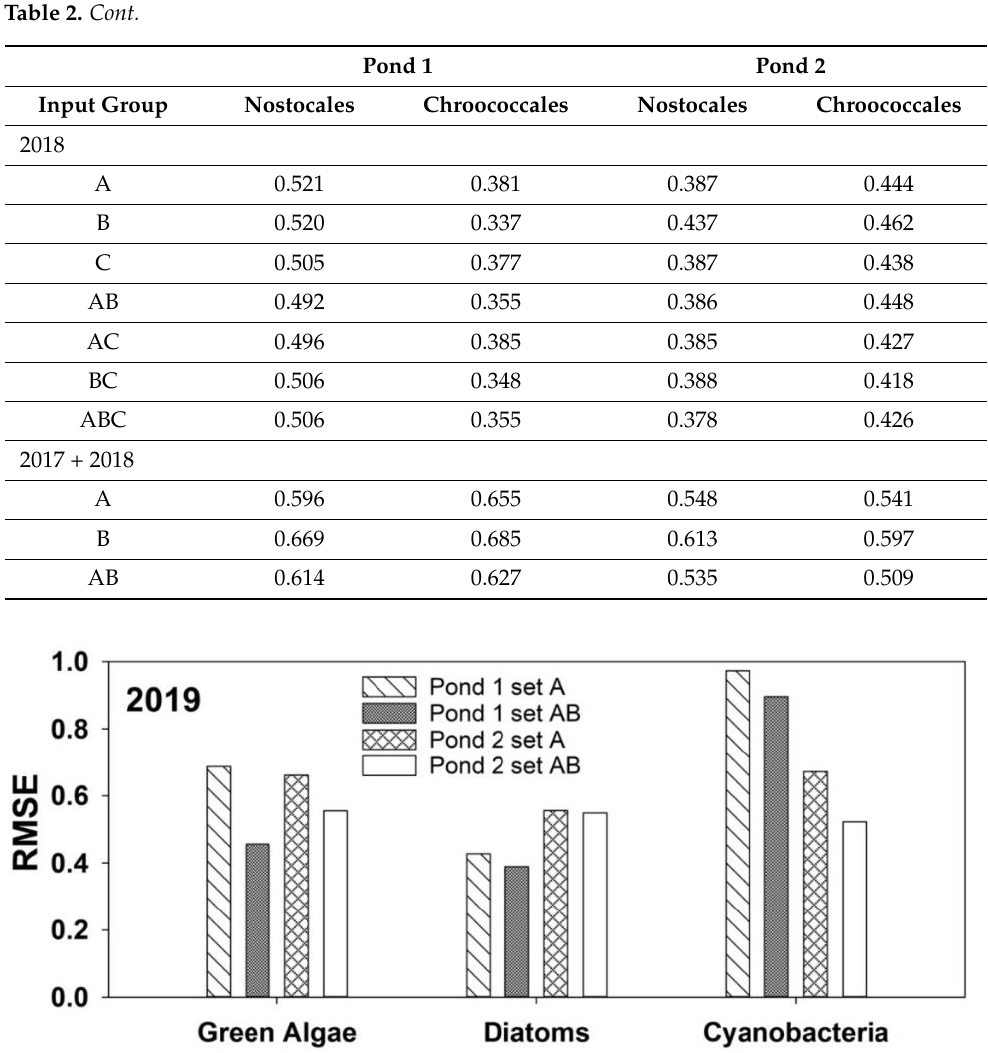
Figure 3. Root-mean-squared errors (RMSEs) of the random forest models for green algae, diatoms, and cyanobacteria for Ponds 1 and 2, with blind data from 2019.